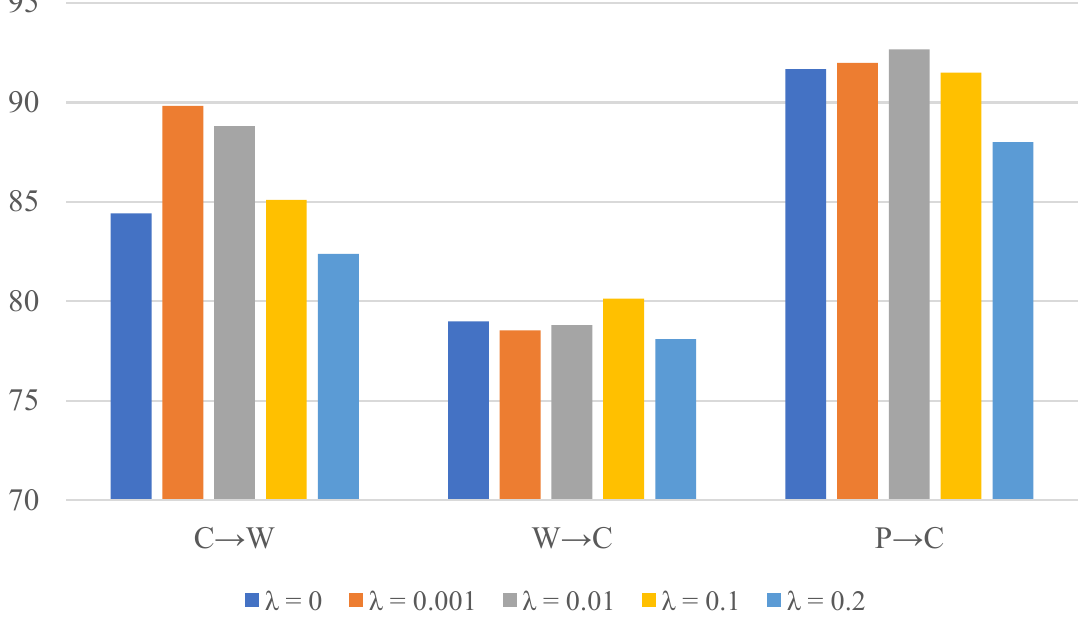
Figure 3. Performance on three subtasks with different λ . X-axis: tasks. Y-axis: